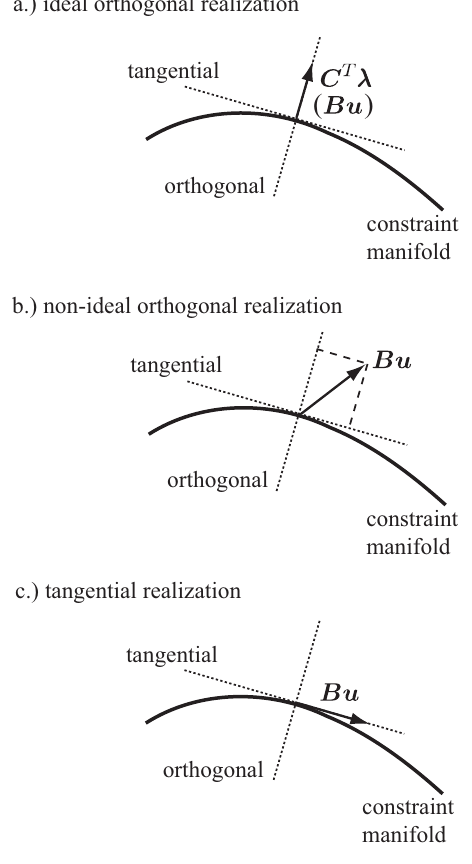
Figure 3. Possible realizations in servo-constraint